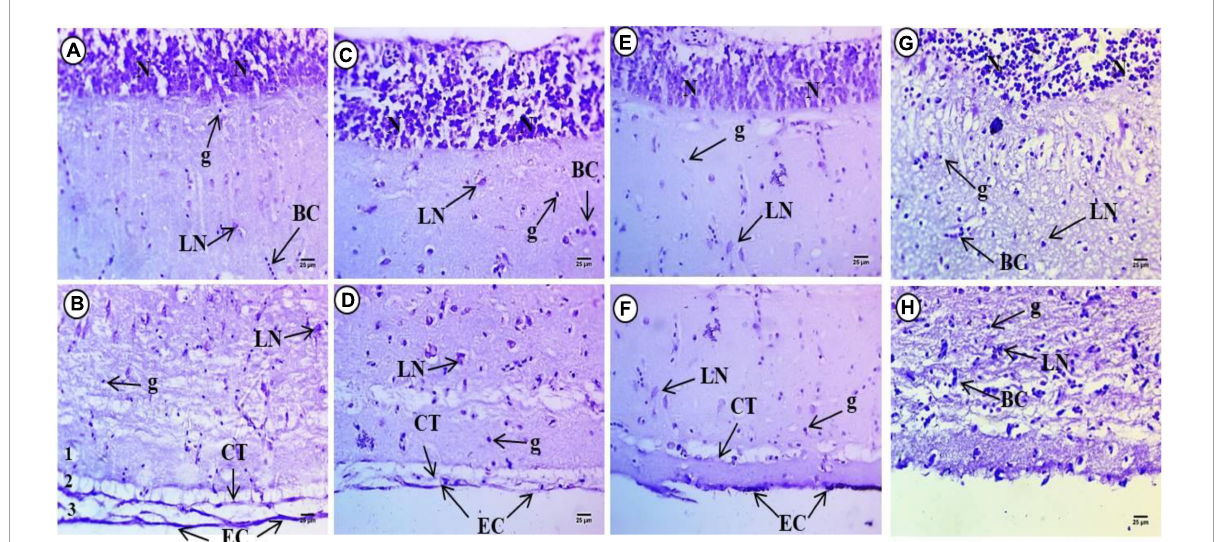
FIGURE2 Sections of control and treated fish brain tissue. (A,B) Sections of control fish brain showing high intensity in internal layer of small neuronal cells (N), large neurons (LN) with faint basophilic Nissl bodies. Deeply stained neurons beside glial cells (g) and deeply stained violet color in the covering connective tissues (CT) and epithelial cells (EC). (C,D) Exposure to 100 mg/L of macroplastic for 15 days showing intensity of violet color in small neuronal cells (N), dispersed different shapes of large neurons (LN) and deeper staining in the covering connective tissues (CT) and epithelial cells (EC). (E,F) Exposure to 100 mg/L of microplastic for 15 days showing slight reduction in color intensity of internal layer small neurons (N), dispersed degenerated large neurons (LN) and less staining in the covering connective tissues (CT) and epithelial cells (EC). (G,H) Exposure to 100 mg/L of nanoplastic for 15 days showing a slight increment in color intensity of internal layer small neurons (N). Dispersed degenerated large neurons (LN) and deep staining in the covering connective tissues (CT) and epithelial cells (EC); (Cresyl violet Stain × 400)